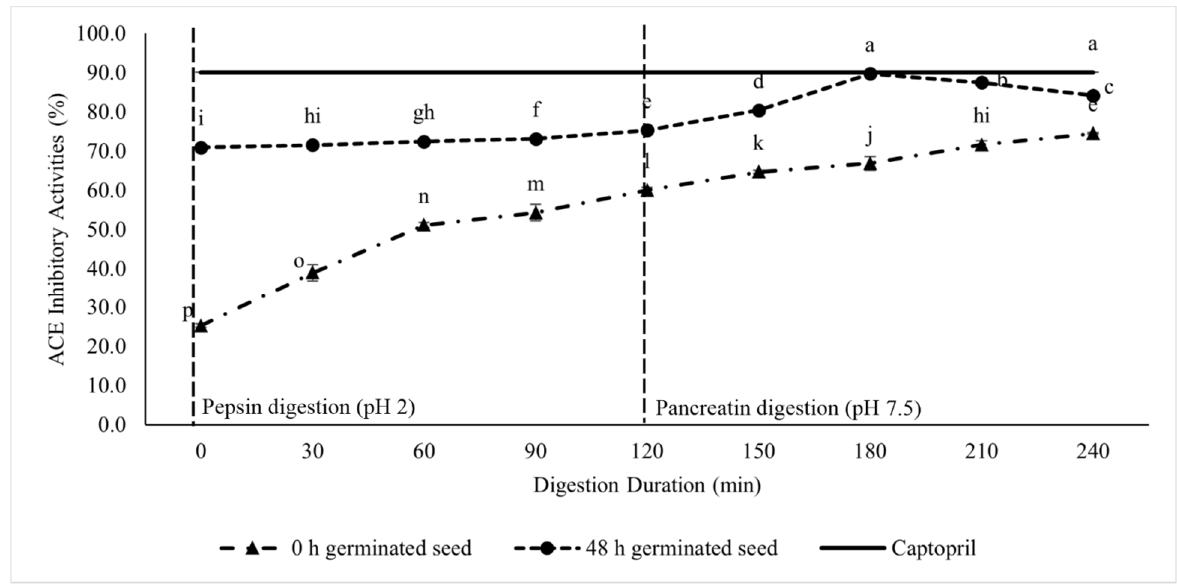
Figure 2. ACE-I activity of the germinated lamtoro gung flour at different digestion durations. Values are means with their SDs. Different letters indicate significant differences between the samples (Duncan’s test, α = 0.05).